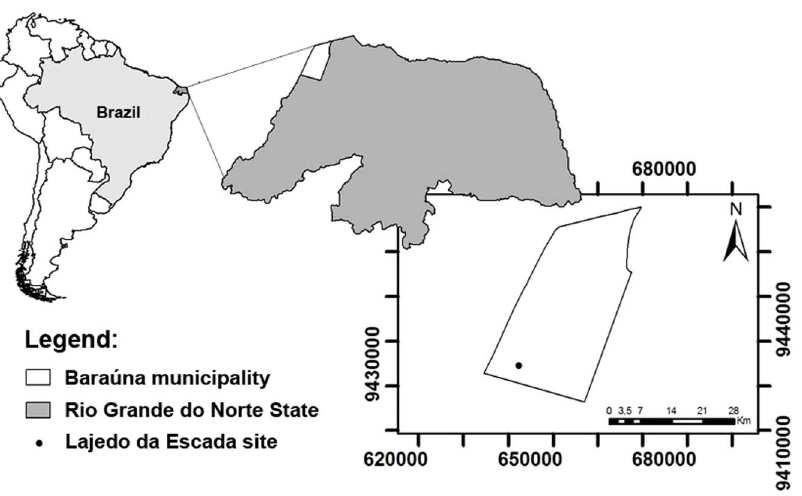
Figure 1. A location map of Lajedo da Escada site in Barau´na municipality, Rio Grande do Norte state, Brazil.